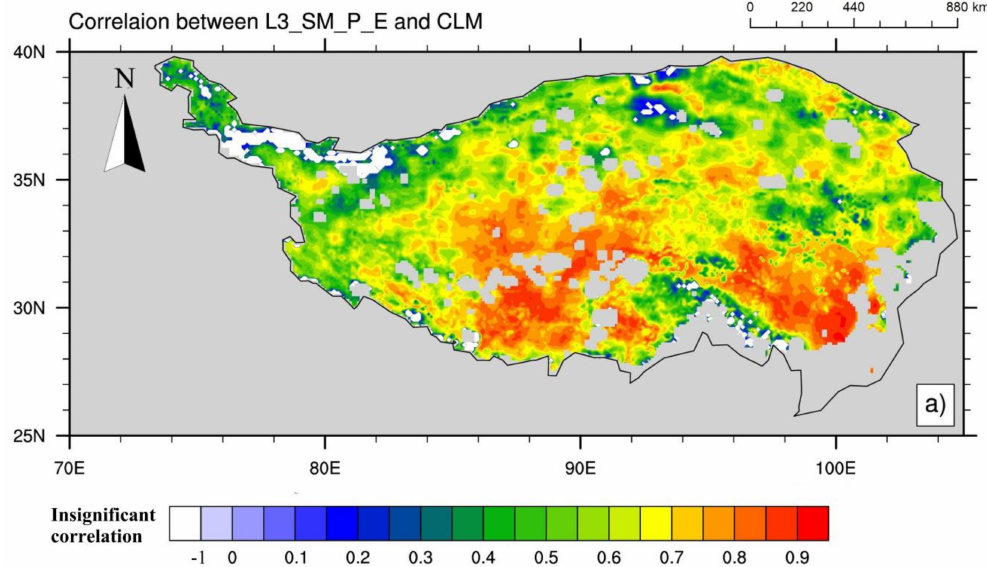
Figure 4. The distribution of the temporal correlation coefficient between SMAP L3_SM_P_E product and Community Land Model (CLM) simulations. Locations where correlations are not significant at the 95% confidence level are masked as white, while locations where soil moisture retrievals were not possible are masked as